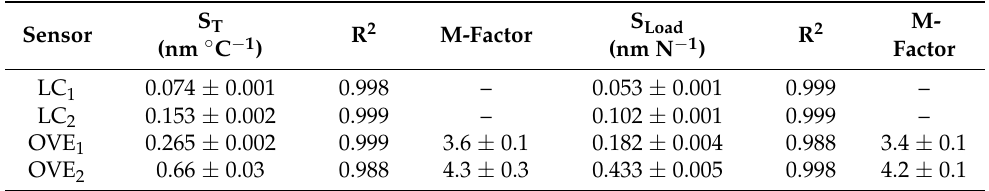
Table 2. Summary of the LC 1 , LC 2 , OVE 1 and OVE 2 sensitivities to temperature (S T ) and normal load (S Load ) variations.